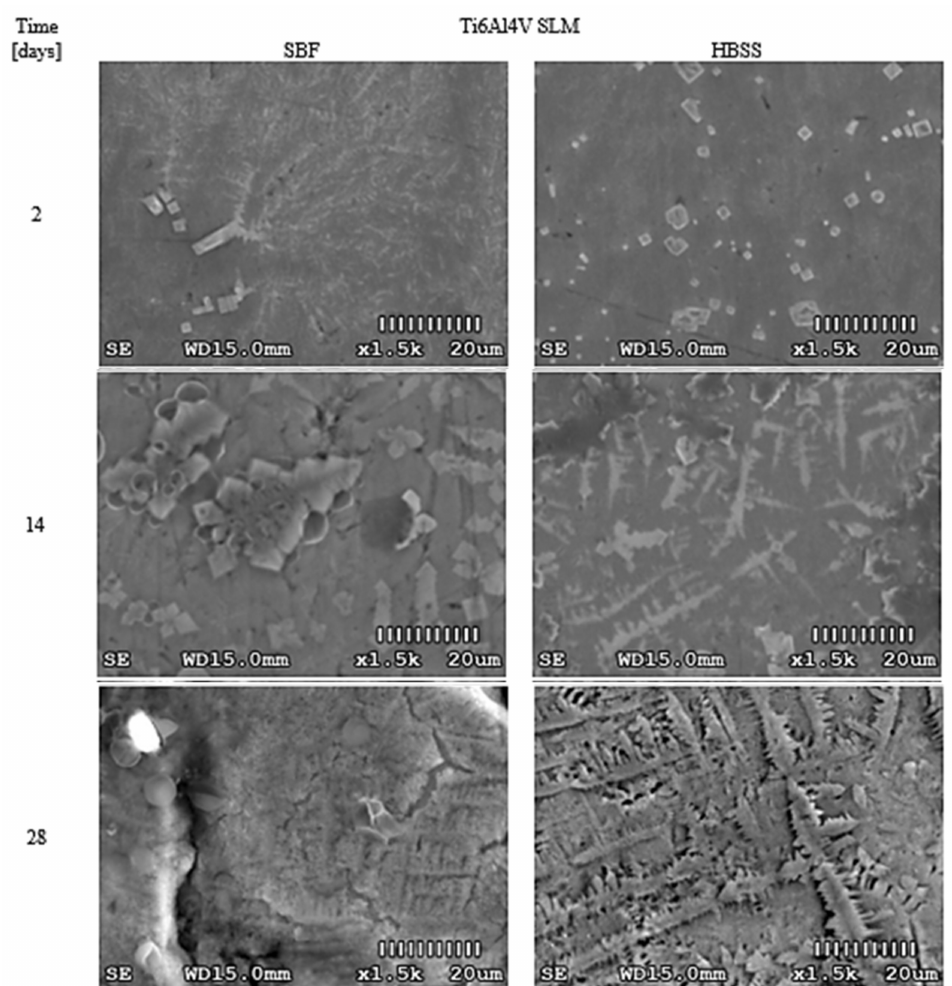
Figure 3. Morphological changes on the surface of Ti6Al4V SLM immersed in SBF and HBSS after selected time